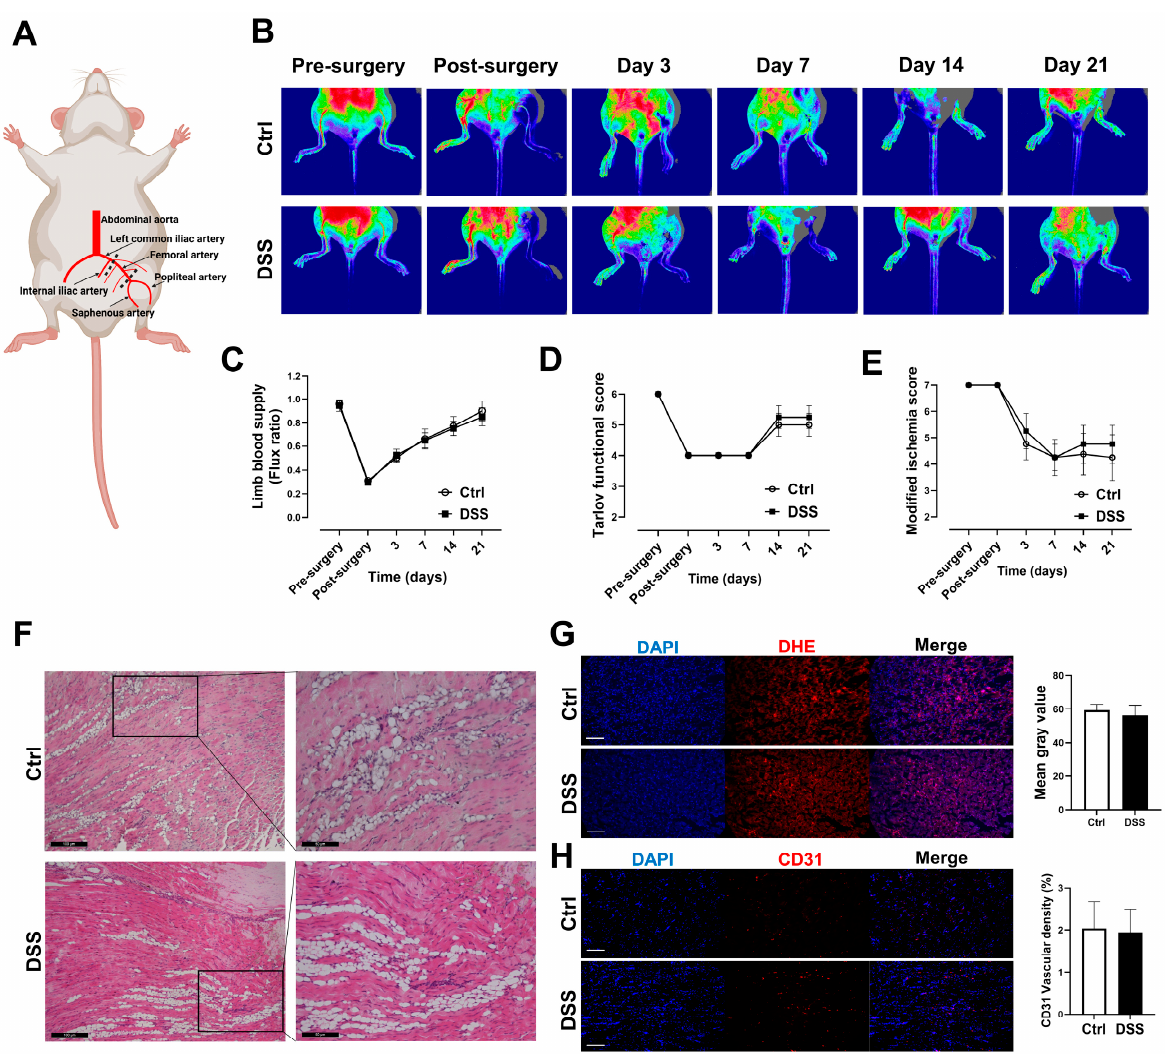
Figure 3. No significant changes in limb ischemia recovery, vascular density, and ROS levels in chronic colitis model. ( A ) Anatomy schematic of unilateral femoral artery ligation. ( B , C ) Analysis of laser doppler perfusion images for limb blood supply. ( D , E ) Functional score and ischemia score to assess limb function. ( F ) Representative images of H&E staining of gastrocnemius muscle from ischemic limb (scale bar, 100 µ m and 50 µ m). ( G ) Representative images of ROS in gastrocnemius muscle from ischemic limb using DHE staining (scale bar, 50 µ m) and graph for quantification of ROS levels in muscle. ( H ) Representative images of vascular density in gastrocnemius muscle from ischemic limb using CD31 immunofluorescent antibody (scale bar, 50 µ m) and graph for quantification of vascular density in muscle. Results are expressed as mean ± SEM. n = 7 mice in each group.